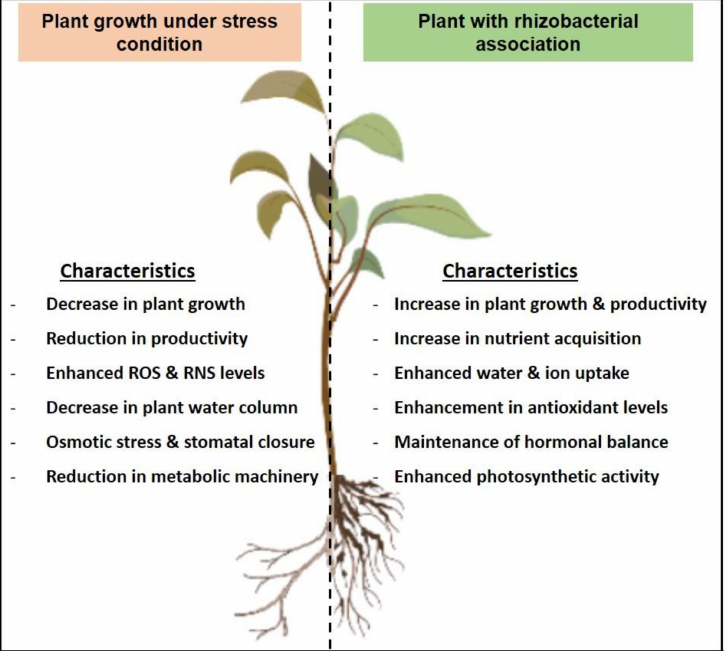
Figure 3. Summarized view of plant-microbiome interactions exerting beneficial effects in